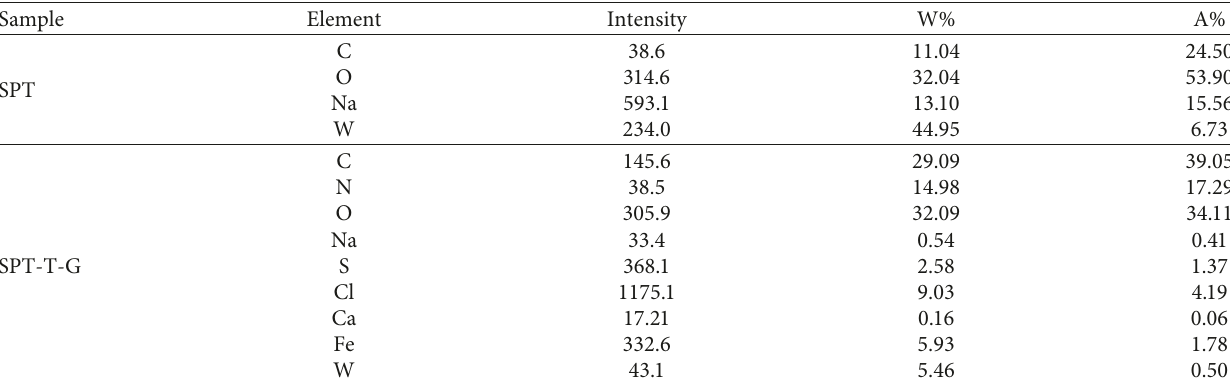
Figure 4: EDAX analysis of (a) SPT and (b) SPT-T-G. Table 2: Quantitative EDAX analysis of SPT and